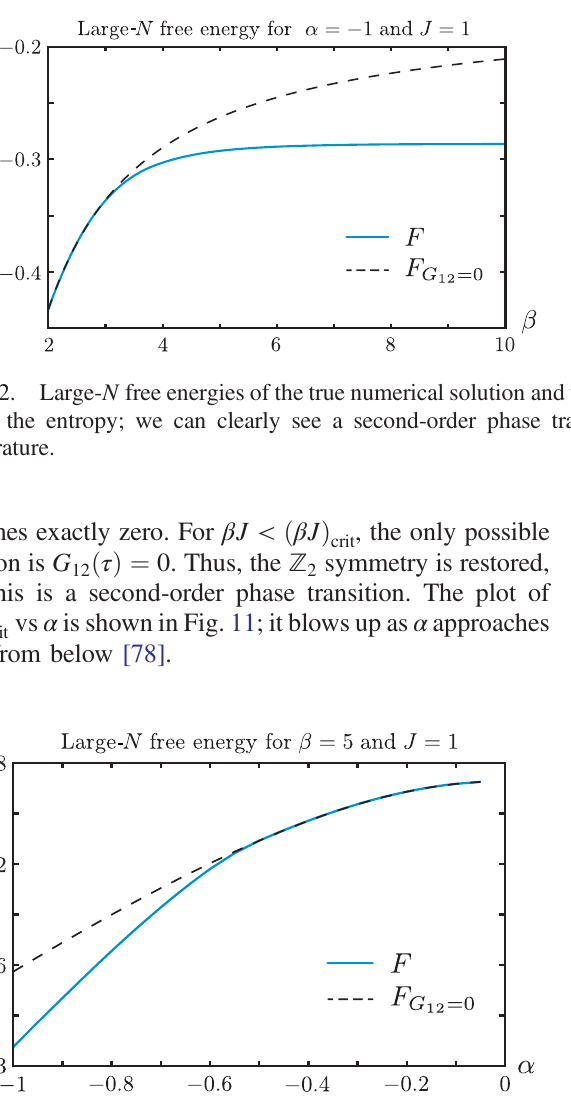
FIG. 13. Large- N free energies at fixed β and J . We take β ¼ 5 , J ¼ 1 , and decrease α . We observe also a second-order phase transition.